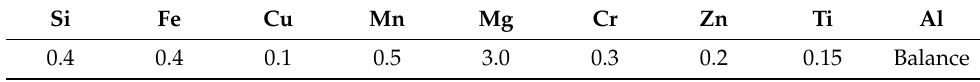
Table 2. Details of the designed lay-ups.